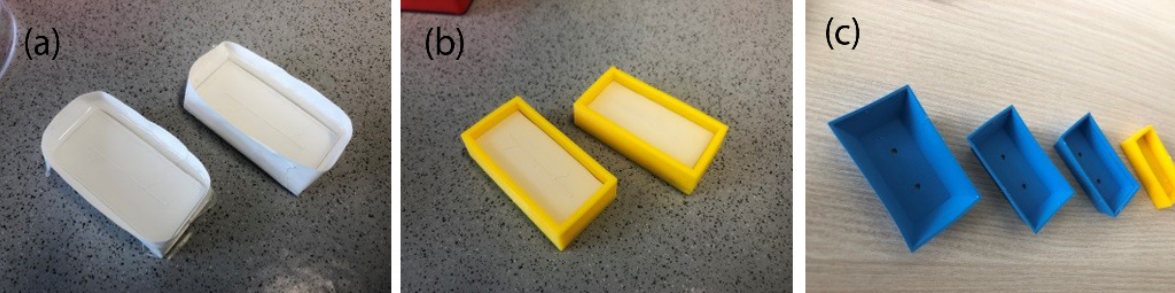
Figure 4. Cases for PDMS pouring. ( a ) Cases with adhesive tape. ( b ) Polylactic acid (PLA) cases with a 90° upstand. ( c ) PLA cases with a 130°, 120° and 110° side wall inclination angle.